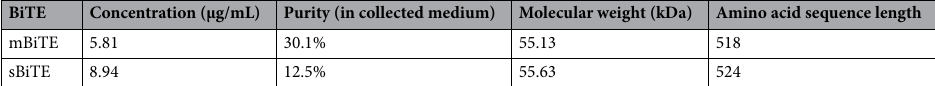
Table 1. Characteristics of the two bispecific T cell engager (BiTE) proteins produced from BiTE-secreting stable cells.